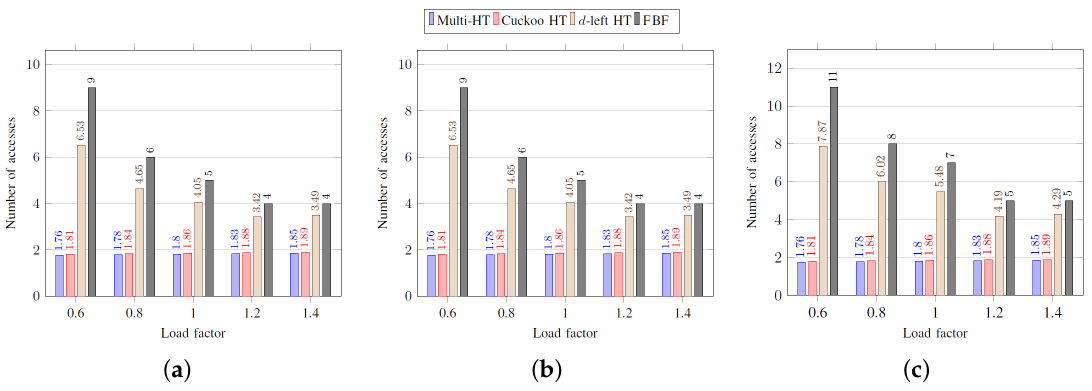
Figure 5. Average number of accesses in a search: ( a ) 8k; ( b ) 32k; ( c ) 130k.